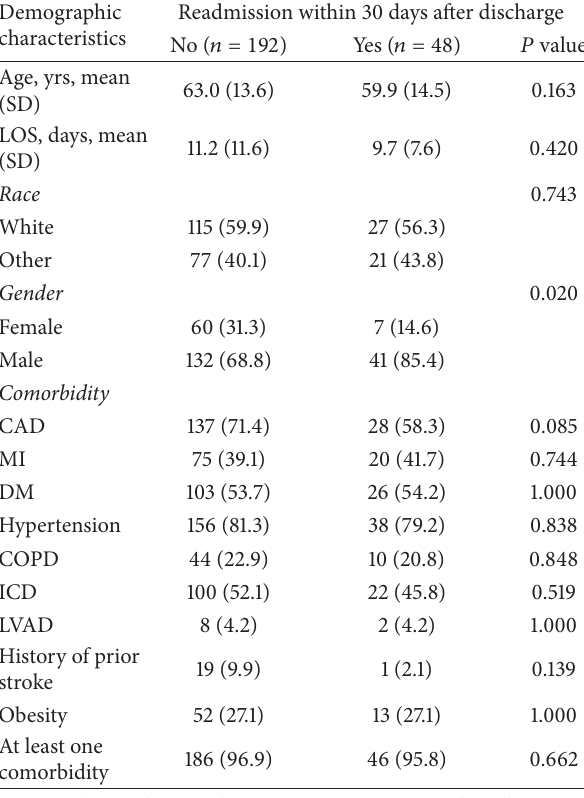
Table 1: Summary of demographic characteristics and medical history between HF readmission and nonreadmission within 30 days after discharge.